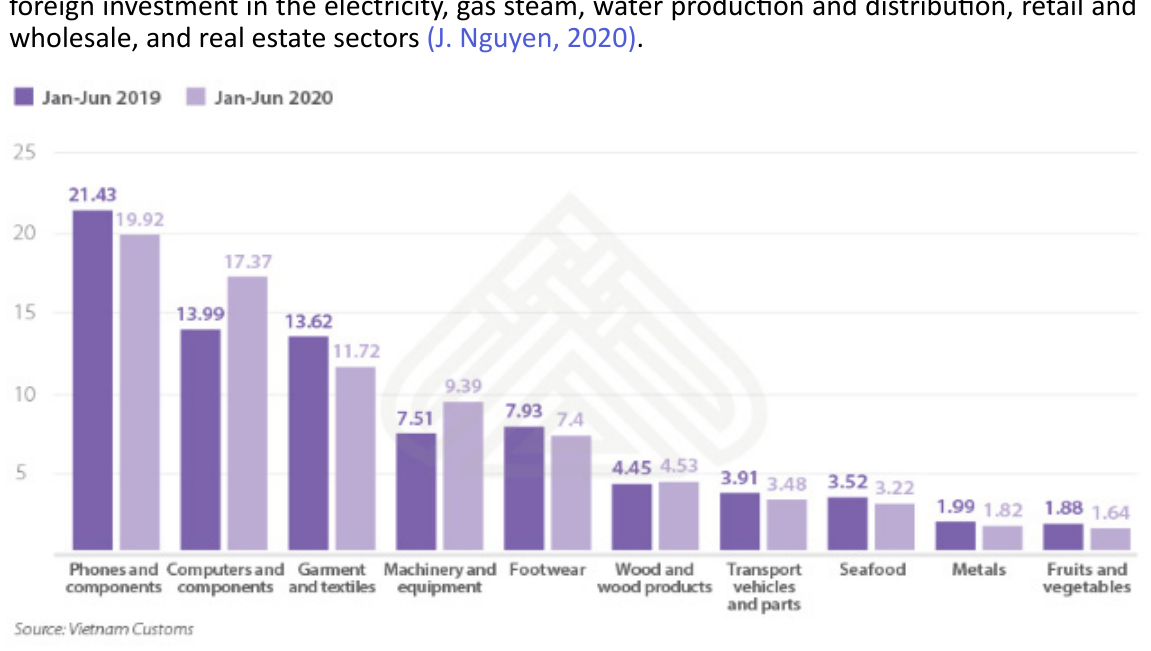
Figure 4: Export Value of Vietnam’s Largest Comodities (billion U$) Source: Nguyen